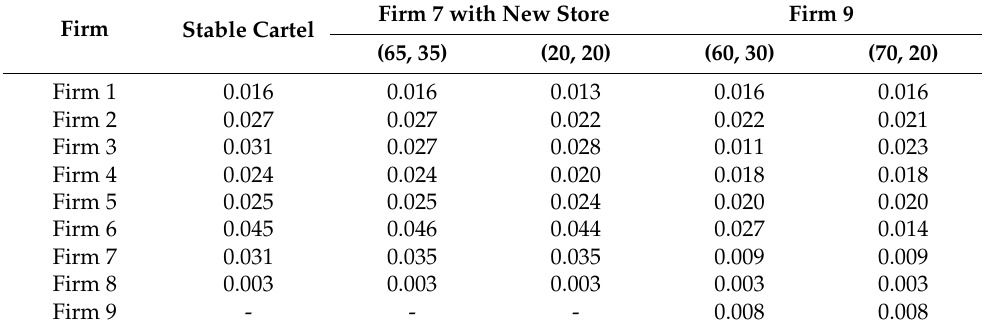
Table 8. Profits after locating a new